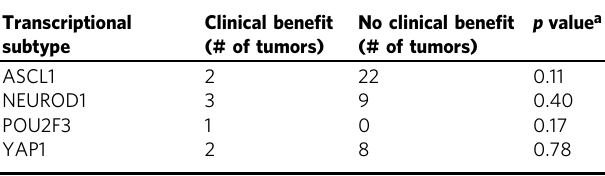
Table 1 Association between transcriptional subtypes and clinical bene fi t to immune checkpoint blockade across relapsed SCLC